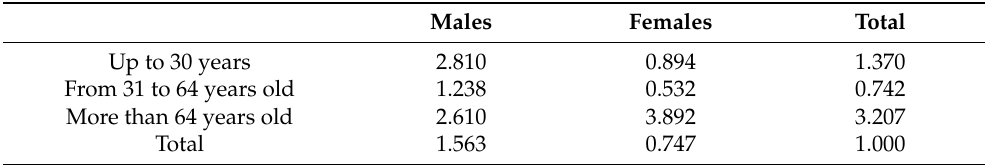
Table 1. Allocation of weights in the weighing of samples. 4 and 9 August 2020; Spain. Weights allocated to each substratum .